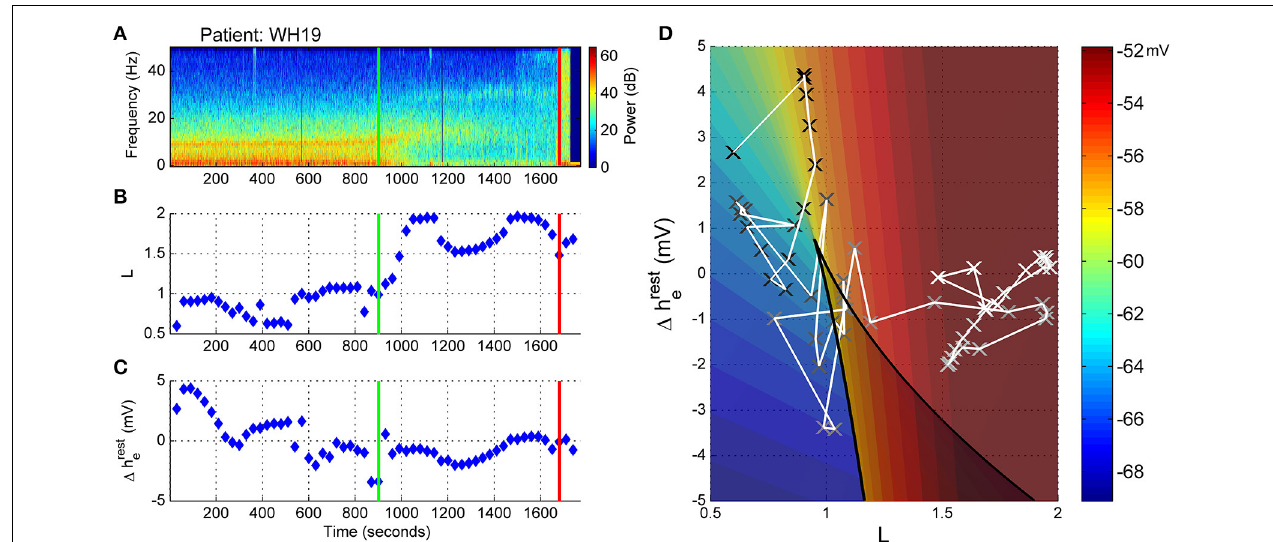
FIGURE 5 | Patient WH19, Sleep Manifold. (A) Spectrogram as in Figure 4 . (B) Excitatory connection strength (L-parameter) over period of observation. (C) Change in resting membrane impedance ( (cid:2) h rest e ) over period of observation. (D) Resultant positioning on the